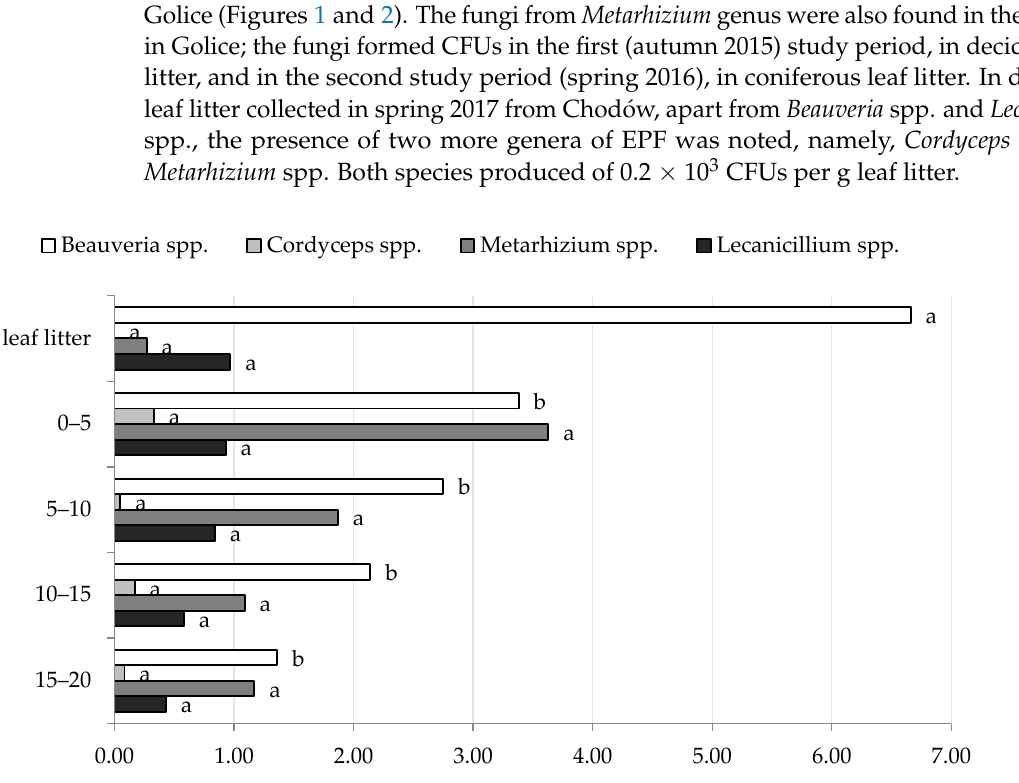
Figure 2. Average density of CFUs of entomopathogenic fungi in the leaf litter and individual layers of forest soils collected in Chodów. abc Statistically significant differences between the concentration of CFUs of entomopathogenic fungi depend- ing on the soil depth.